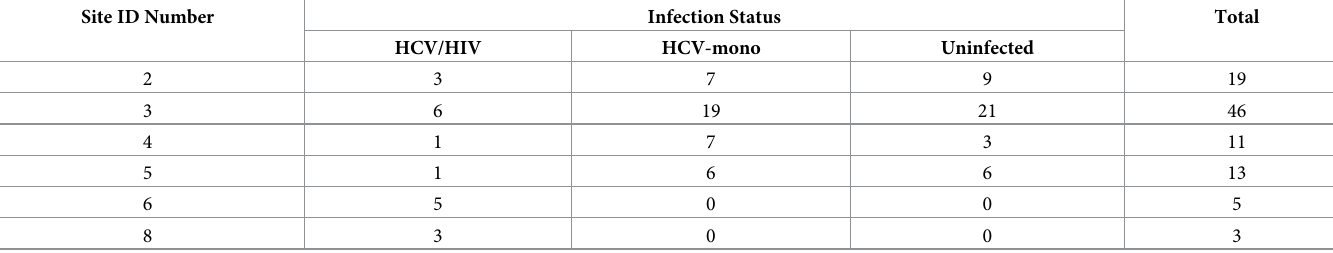
Table 1. Distribution of participants by recruitment site and infection status. Site ID